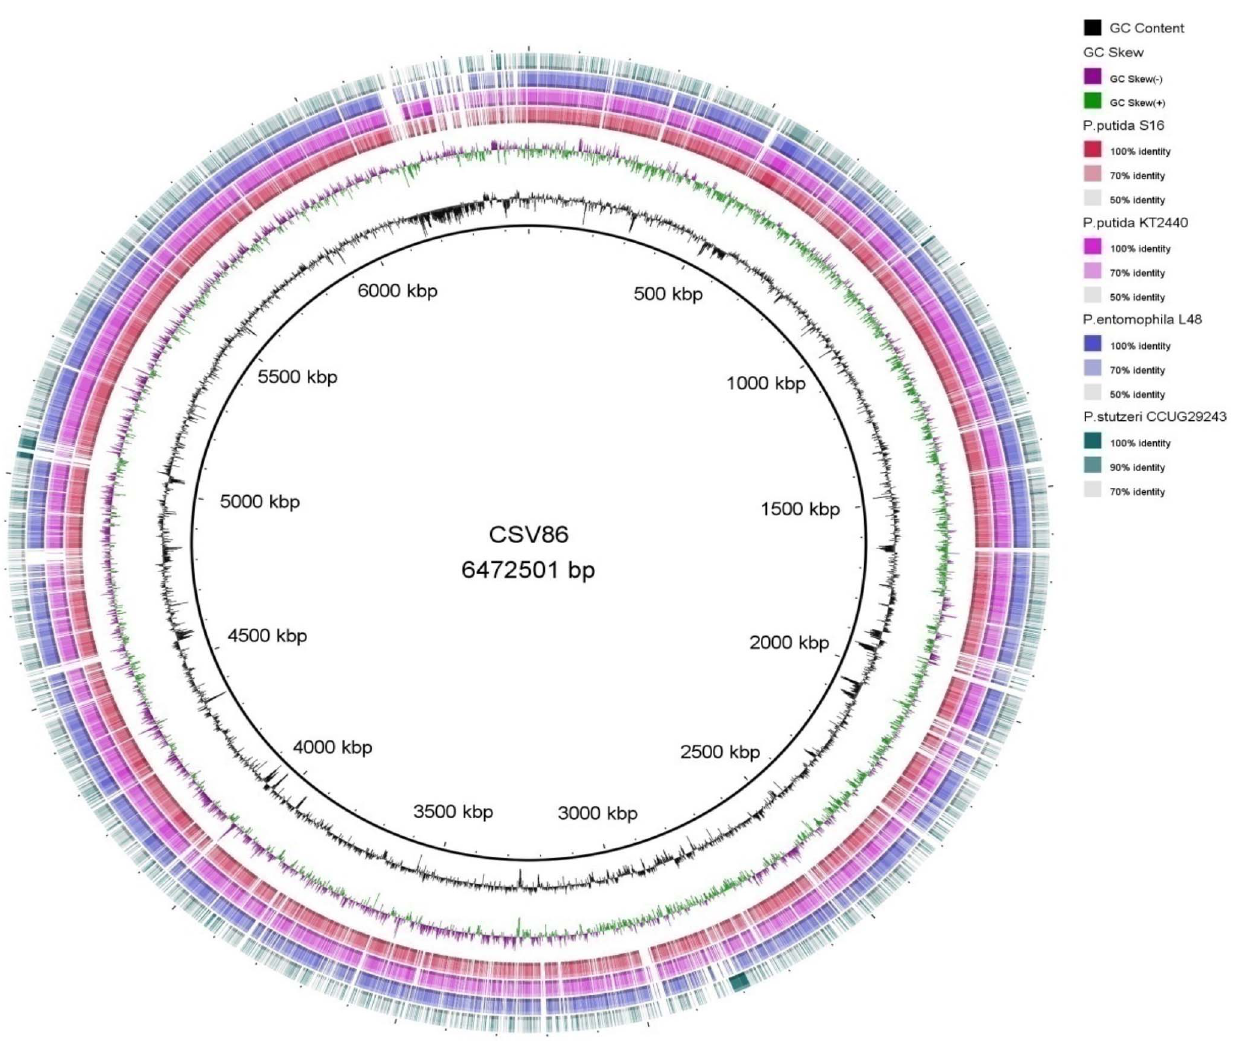
Figure 2. BLAST comparison of draft genome of Pseudomonasputida CSV86 against four Pseudomonas species, using BRIG. The innermost rings depict GC content (Black) and GC Skew (purple/green) followed by concentric rings of query sequences colored according to BLAST identity. The outermost rings depict genomes of the following microbes- P. putida S16 (Red), P. putida KT2440 (Pink) P. entomophila L48 (Blue), and P. stutzeri CCUG 29243 (Green).